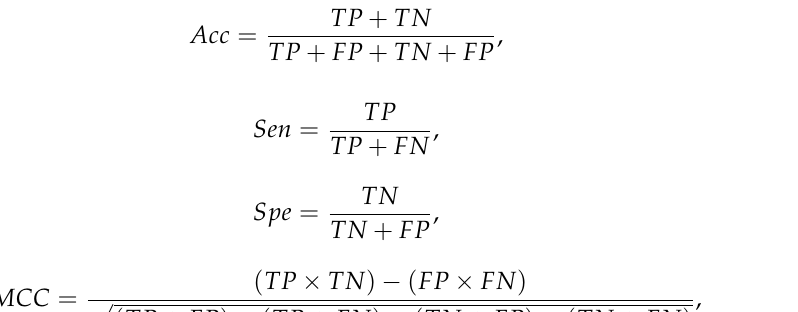
gories; Table S1: Comparison of ML classifiers tested for Gram+ AMP prediction (10 Times 10-Fold Cross-Validation; Table S2: Comparison of ML classifiers tested for Gram − AMP prediction (10 Times 10-Fold Cross-Validation; Table S3: Results of ML classifiers created for Gram+ AMP prediction; Table S4: Results of ML classifiers created for Gram − AMP prediction; Figure S5: Matrix of la- bels for the common peptides between training dataset of CalcAMP+ and CalcAMP- models and AmPEP external benchmark dataset; Table S5: Comparison of different AMP prediction classifiers using AmPEP benchmark dataset; Figure S6: Receiver operator characteristic (ROC) curves of the different AMP classifiers and their area under the curve score obtained using AmPEP external benchmark dataset; Figure S7: Matrix of labels for the common peptides between training dataset of CalcAMP+ and CalcAMP- models and adapted Antimicrobial Peptide Scanner vr.2 validation dataset; Table S6: Comparison of different AMP prediction classifiers using adapted Antimicrobial Peptide Scanner vr.2 validation dataset; Figure S8: Receiver operator characteristic (ROC) curves of